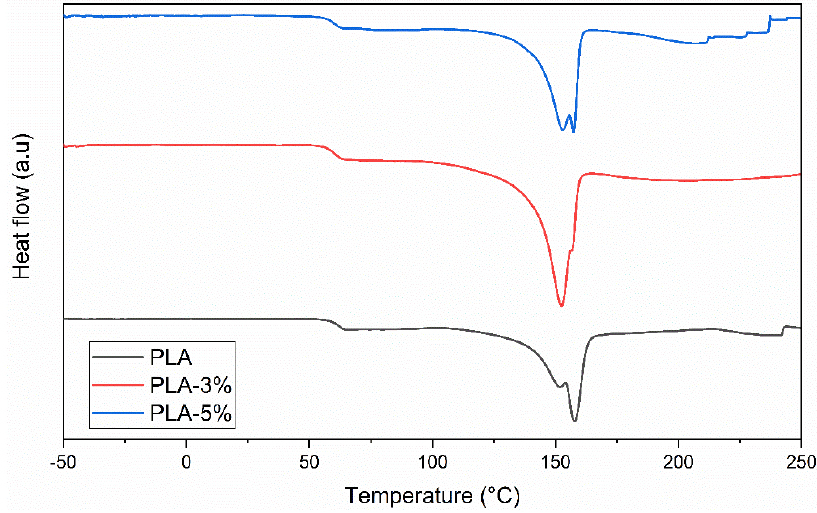
Figure 2. Differential scanning calorimetry curves of PLA-0%, PLA-3%, and PLA-5%CaCO 3.